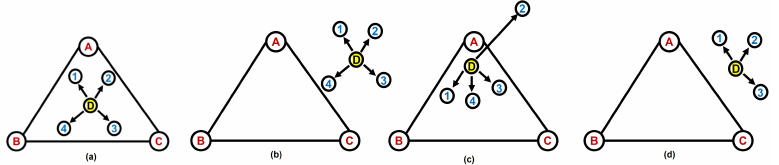
Figure 7. Approximate Point in Triangulation (APIT) localization technique, reproduced with per- mission from Chen, An Indoor Collaborative Coefficient-Triangle APIT Localization Algorithm; published by MDPI, 2017. ( a ) The receiving nodes are determined as being inside the triangle; ( b ) the receiving nodes are determined as being outside the triangle; ( c ) “InToOut” error; ( d ) “OutToIn” error.